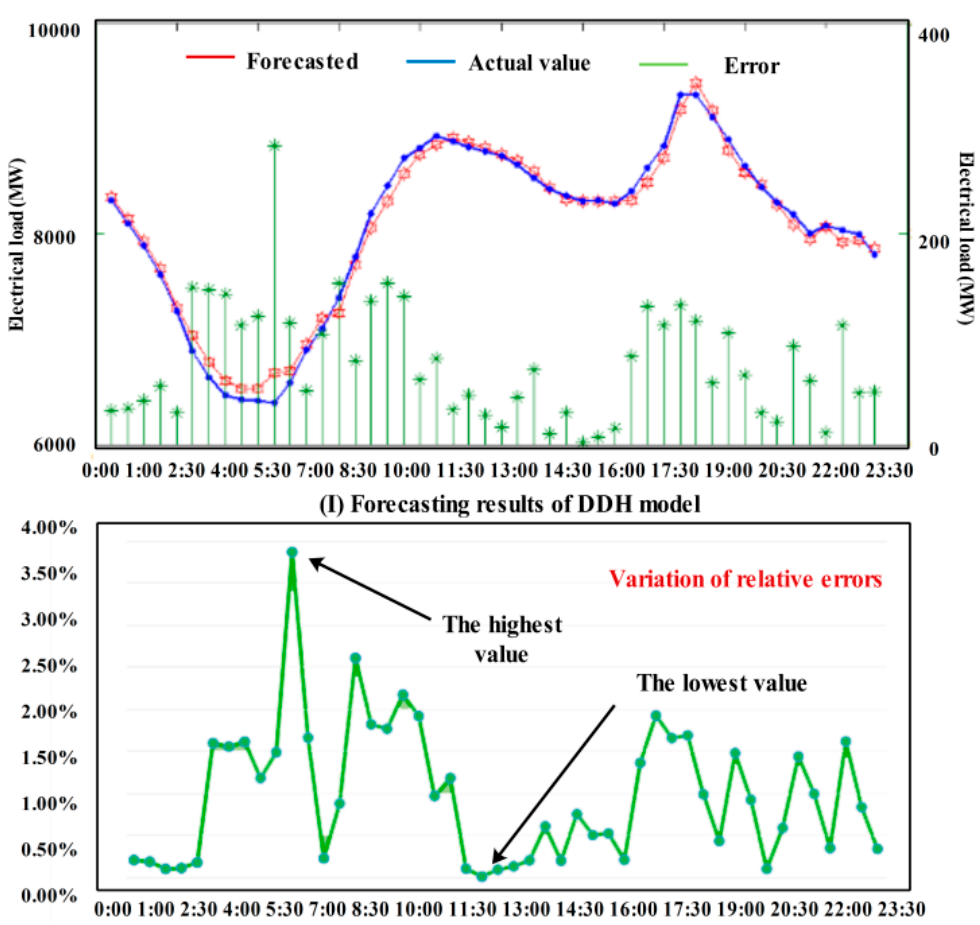
Figure 6. Forecasting results and MAPE of DDH model.